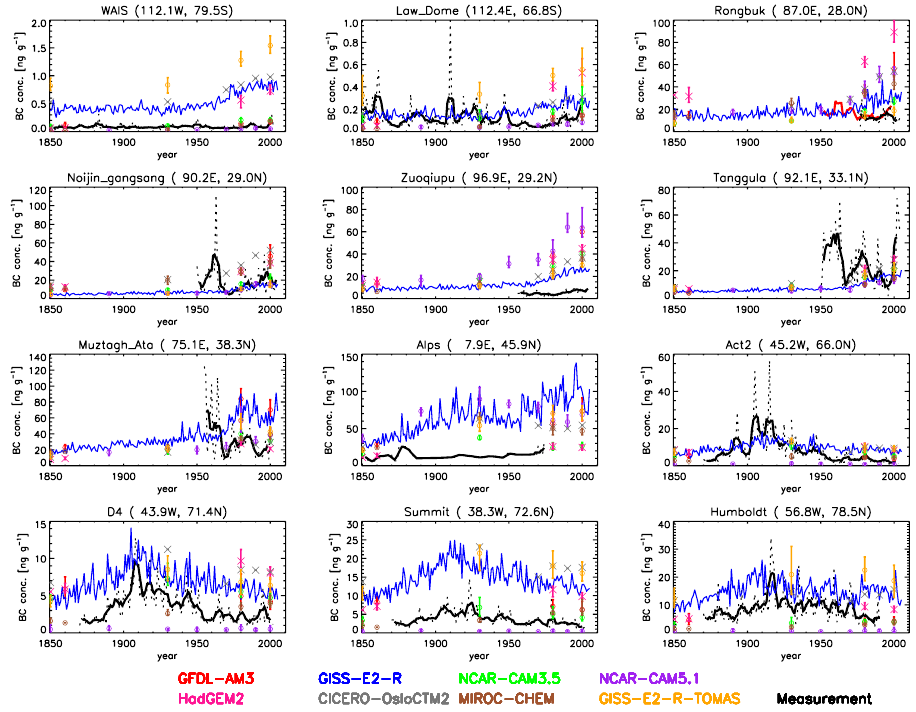
Fig. 12. Same as Fig. 11 but for BC snow concentrations. The red thick line in Rongbuk is BC ice core data from Ming et al. (2008). Note that, unlike Fig. 11, the ACCMIP timeslice simulations for NCAR-CAM3.5 and MIROC-CHEM are